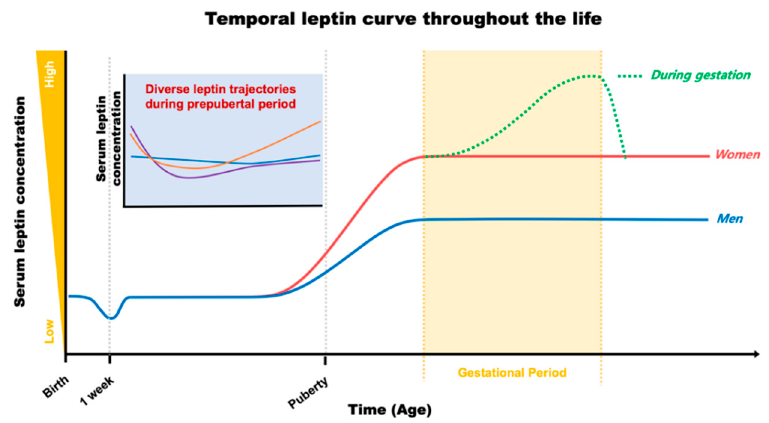
Figure 1. Plasma leptin trajectories throughout the life in humans.